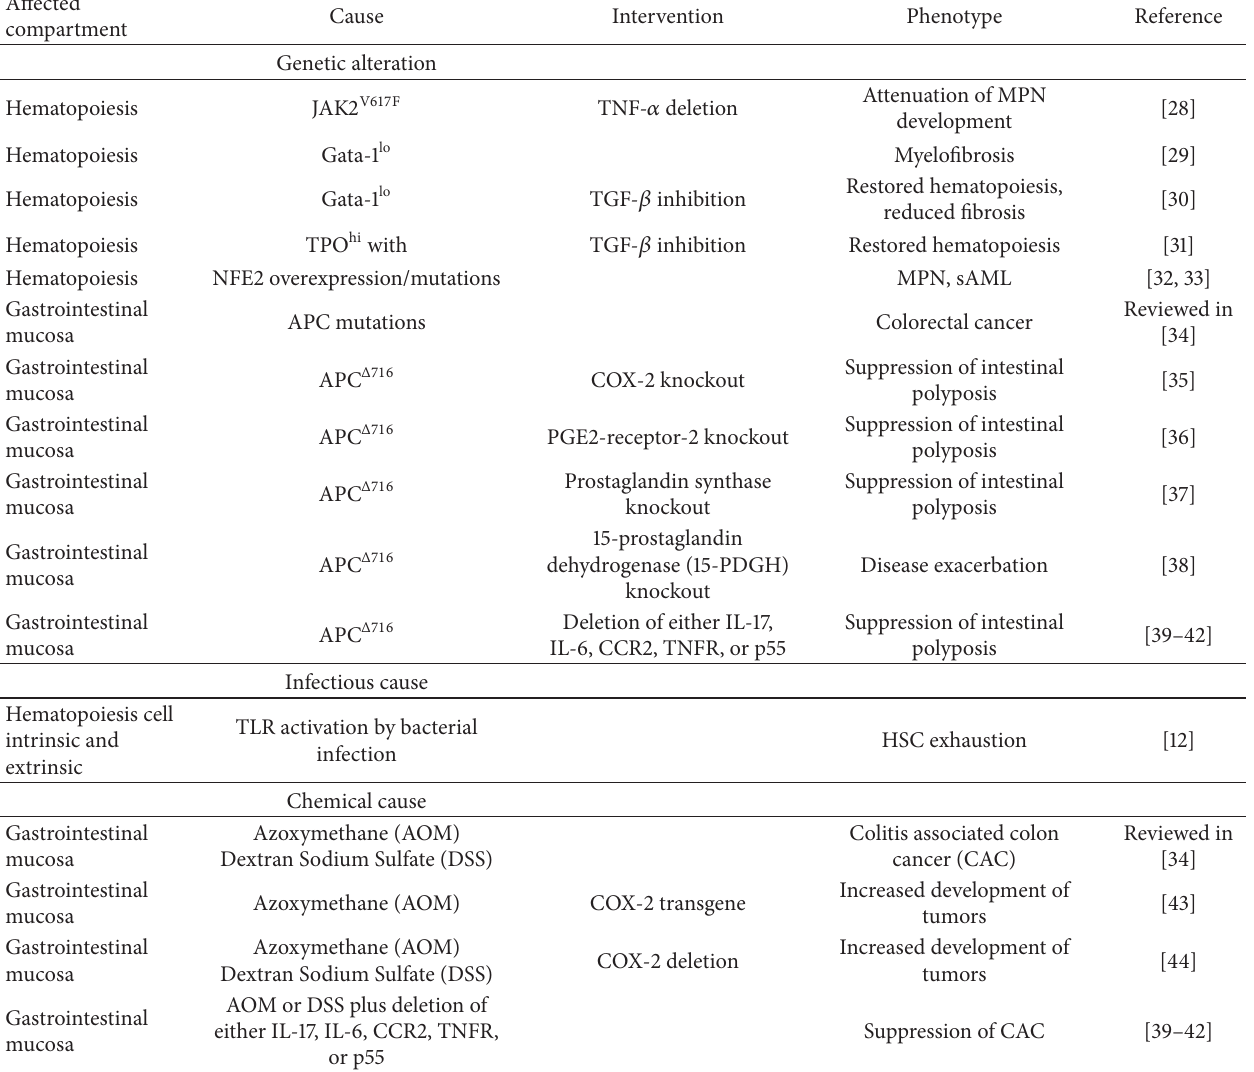
Table 1: Disease models involving